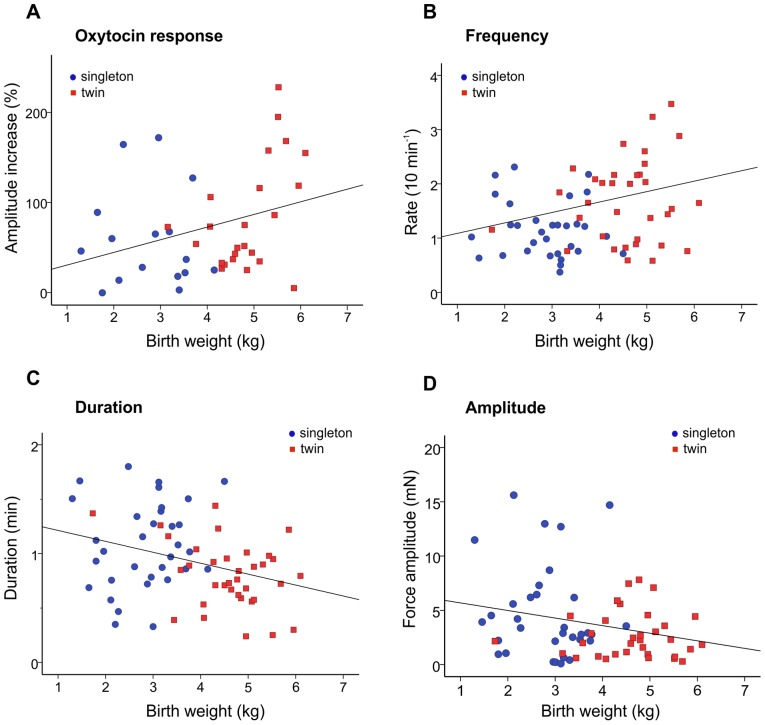
Contractile responses in relation to birth weight.Plots of the different contractile properties of strips of myometrium from women undergoing Caesarean section delivery with singleton (n = 35) or twin pregnancy (n = 48) against birth weight. (A) Response of the myometrium to 10 nM oxytocin, as percent increase relative to spontaneous contraction amplitude. (B) Frequency of spontaneous contractions (rate in 10 min). (C) Duration of spontaneous contractions (min). (D) Force amplitude of spontaneous contraction (mN). Increasing neonatal birth weight was significantly positively correlated with oxytocin response (A) and frequency of contraction (B), but negatively correlated with duration of contraction (C) and amplitude of contraction (D). In the case of twin pregnancy, birth weight is the combined weight of both babies. Data from myometrium from singleton pregnancies is denoted by blue circles and data from myometrium from twin pregnancies is denoted by red squares.